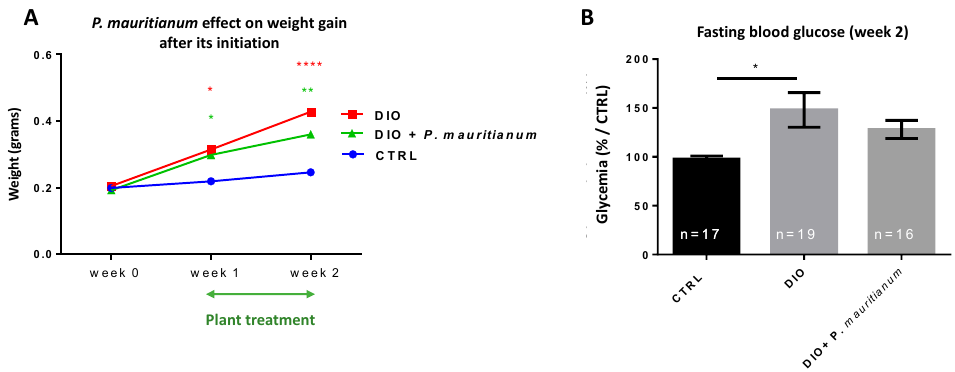
Figure 11. Aqueous extract of P. mauritianum limited the increase in body weight and glycemia after the onset of weight gain. ( A ) Line graph showing the increase in the body weight during the experiment from week 0 to week 2 in the CTRL, DIO and DIO + P. mauritianum groups. The green “double arrow” represents the plant treatment from week 1 to week 2. ( B ) Bar graph showing fasting blood glucose of CTRL, DIO and DIO + P. mauritianum at the end of the experimental procedure (week 2). n = 16–19, number of fish. Bar graph: standard error of the mean (SEM). Two-way ANOVA ( A ); one-way ANOVA ( B ): * p < 0.05; ** p < 0.01; **** p < 0.0001.